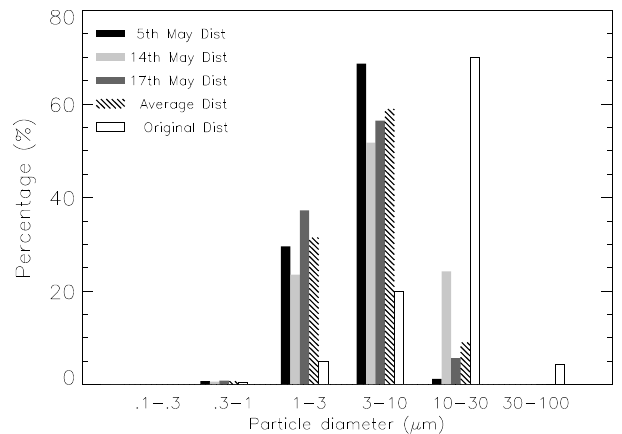
Fig. 5. Distribution of total column mass for distal particle size dis-